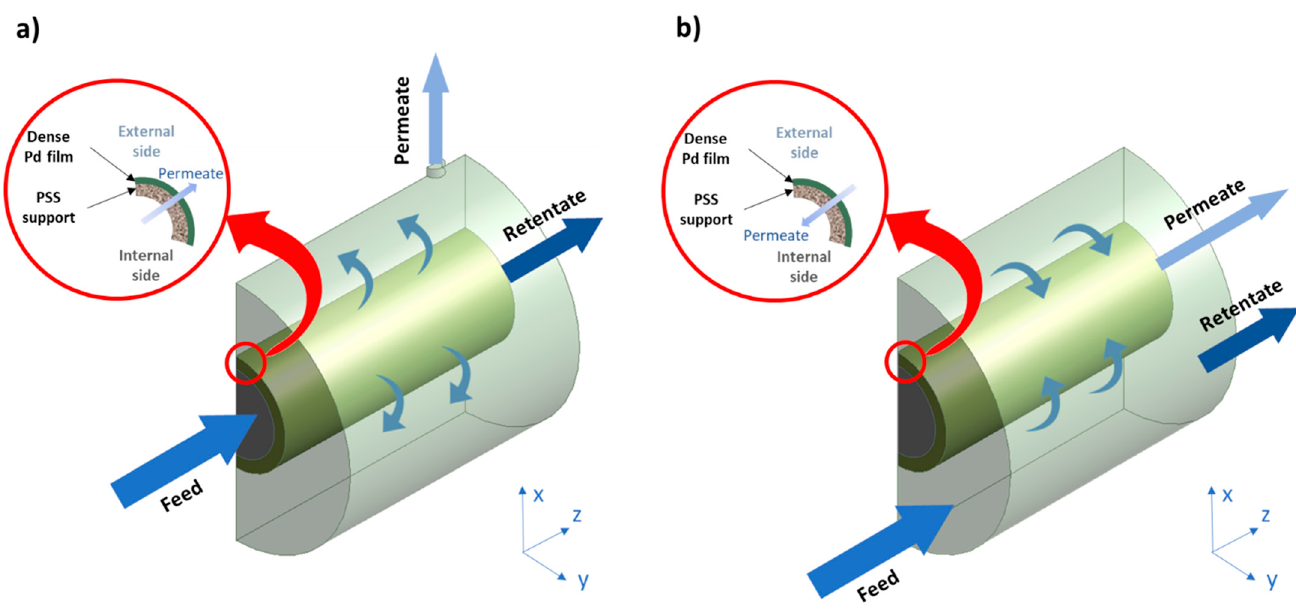
Figure 1. Schematic representation of the membrane permeator working in two different configurations: ( a ) in–out and ( b ) out–in. PSS: porous stainless steel.